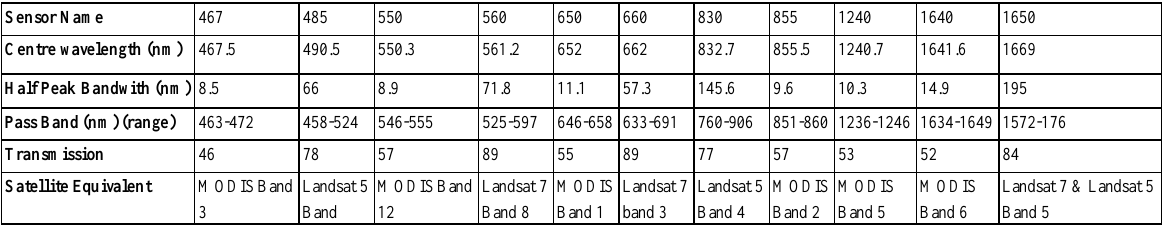
Table 2: Filters fitted to the CROPSCAN MSR Reflectance is measured using a hand-held Multi-